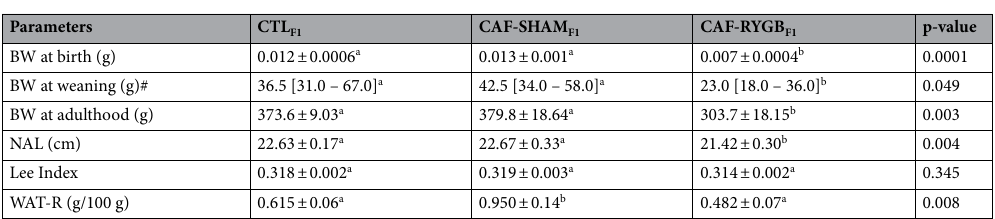
Table 1. Effect of maternal obesity and RYGB on the anthropometric parameters of male adult offspring rats. BW, body weight; NAL, naso-anal length; WAT-R, white adipose tissue- retroperitoneal; AUC, area under curve; g, gram; cm, centimetre. Offspring ( F1 ): CTL F1 : Offspring from dams that consumed rodent chow diet throughout life and were not operated; CAF-SHAM F1 : Offspring from dams that consumed CAF diet throughout life and were submitted to SHAM surgery; CAF-RYGB F1 : Offspring from dams that consumed CAF diet throughout life and were submitted to RYGB (n = 6 rats/groups). Data are means ± SEM. Different letters represent statistical differences between the groups. One-way ANOVA, Bonferroni post-test (p < 0.05). # Kruskall-Wallis, Dunn’s test (p < 0.05), median and 25th and 75th percentiles.